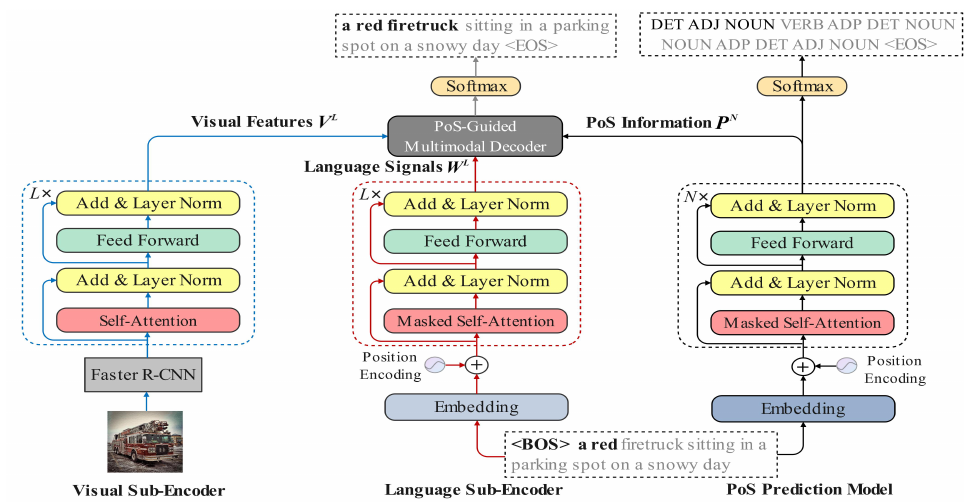
Figure 2. The overall architecture of PoS-Transformer for image captioning. Our framework consists of four parts: the visual subencoder, the language subencoder, the PoS predictor, and the PoS-guided multimodal decoder. The captioning generation includes three steps: (1) encoding the visual features and language signals separately; (2) obtaining the PoS information by predicting the subsequent PoS; and (3) generating the final caption with PoS guidance to the usage of visual and language cues. Our PoS-Transformer can dynamically adjust the weights between visual features and language signals to produce more fine-grained